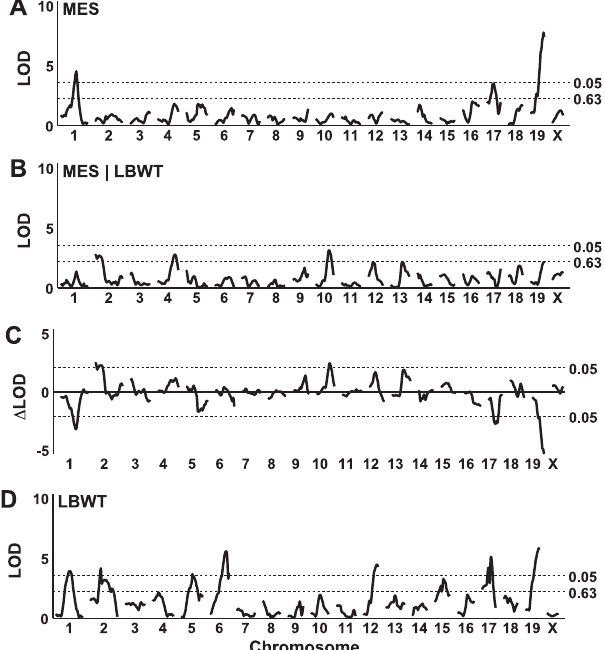
Figure 3. Genome-Wide Scans for Mesenteric Fat Pad Weight at 2 cM Resolution Genome scans shown are (A) mesenteric fat pad weight with sex as an additive covariate; (B) mesenteric fat pad weight with sex and lean body weight as additive covariates; (C) difference in LOD scores between scans in (A) and (B); and (D) lean body weight with sex as an additive covariate. LBWT, lean body weight; MES, mesenteric fat pad weight. DOI: 10.1371/journal.pgen.0020114.g003